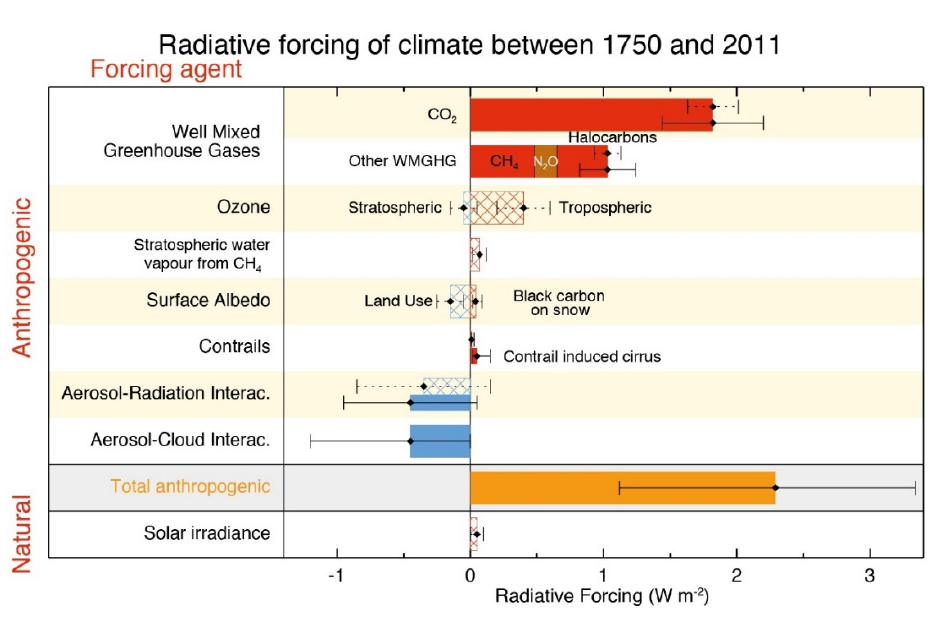
Figure 3. Figure reproduced from Figure 8.15, Chapter 8 of the AR5, IPCC